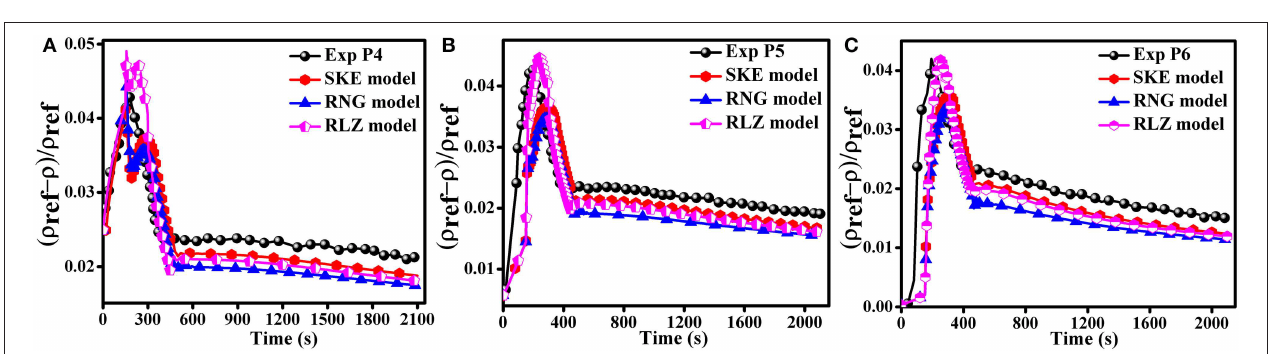
FIGURE 8 | Effect of air-injection velocity 5.143 m/s on the simulation results for monitors (A) P4, (B) P5, and (C) P6.